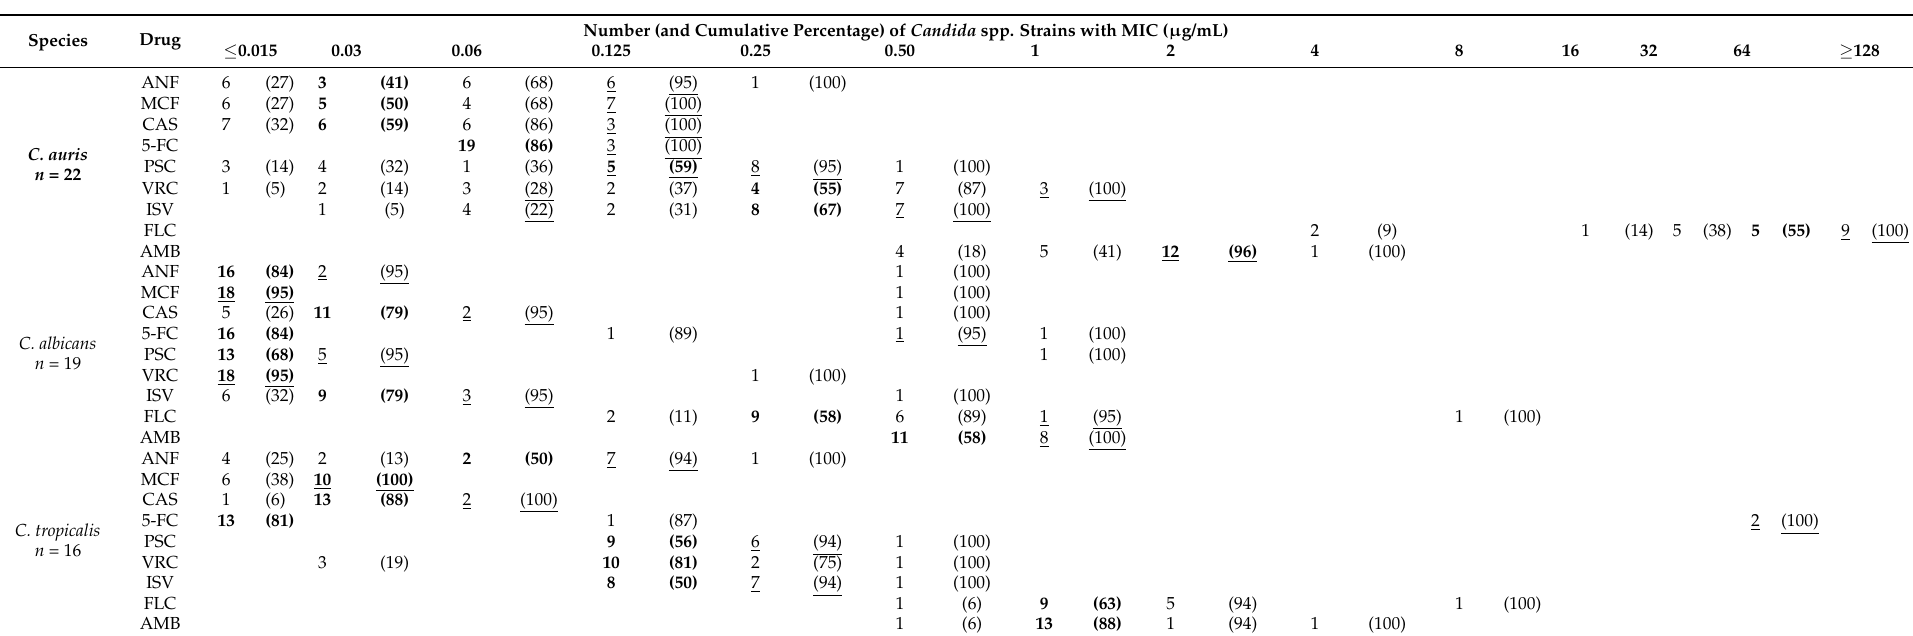
Table 2. Antifungal activities of the nine tested drugs against C. auris ( n = 22) and NACS ( n =